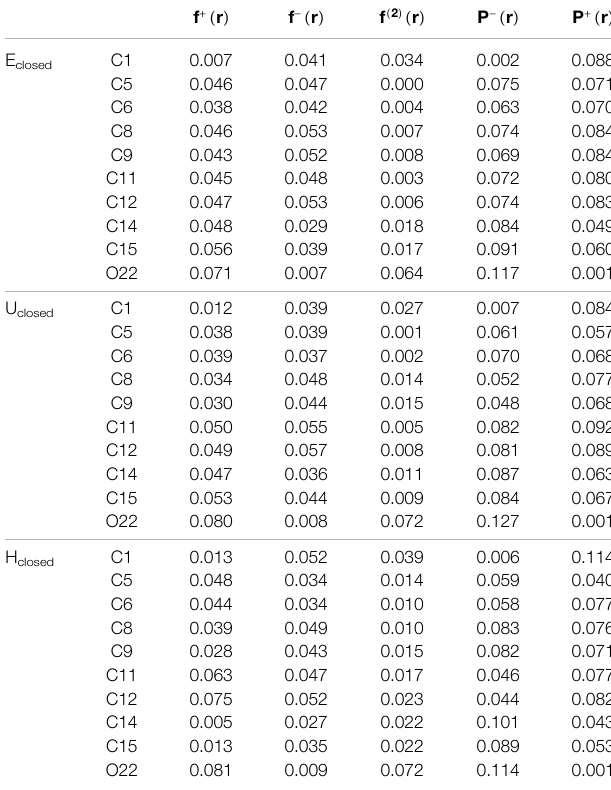
TABLE 2 | Fukui functions, f + ( r ) and f − ( r ) , dual descriptor, f ( 2 ) ( r ) , and Parr functions, P − ( r ) and P + ( r ) theconformersofanandamide:E closed ,U closed ,and H closed , obtained at the BP86/cc-pVTZ level of theory in